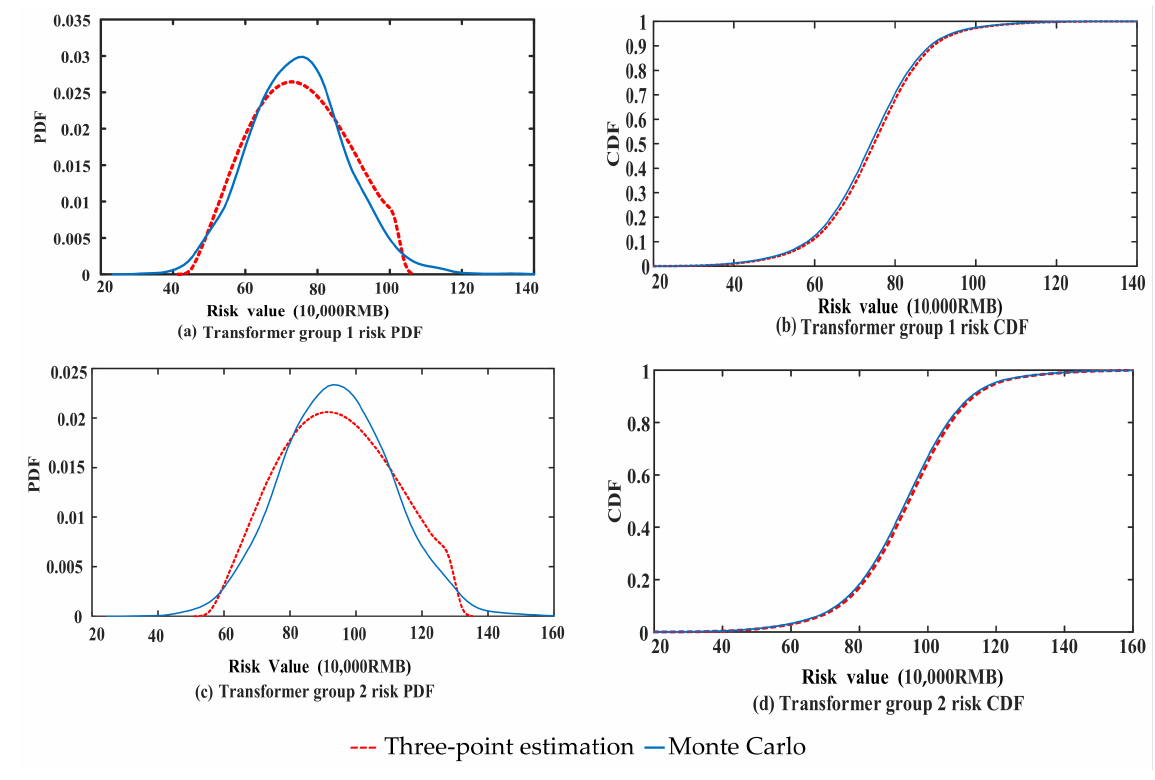
Figure 5. PDF and CDF of Transformer 1 risk. Table 8. The grade normal cloud model corresponds to grey number B ( ⊗ ) of the three-parameter